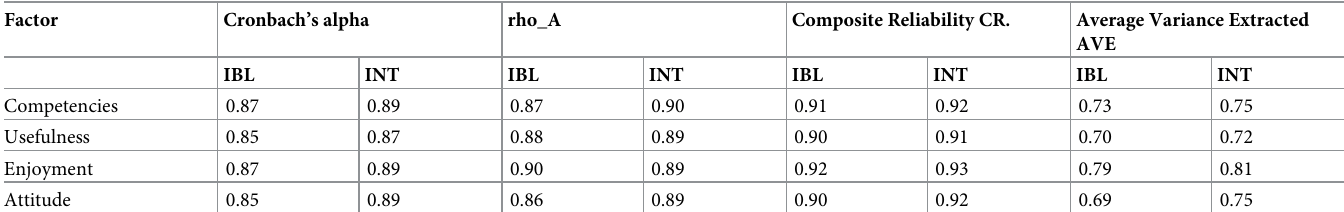
Table 6. Reliability and validity for IBL and INT teaching strategies.